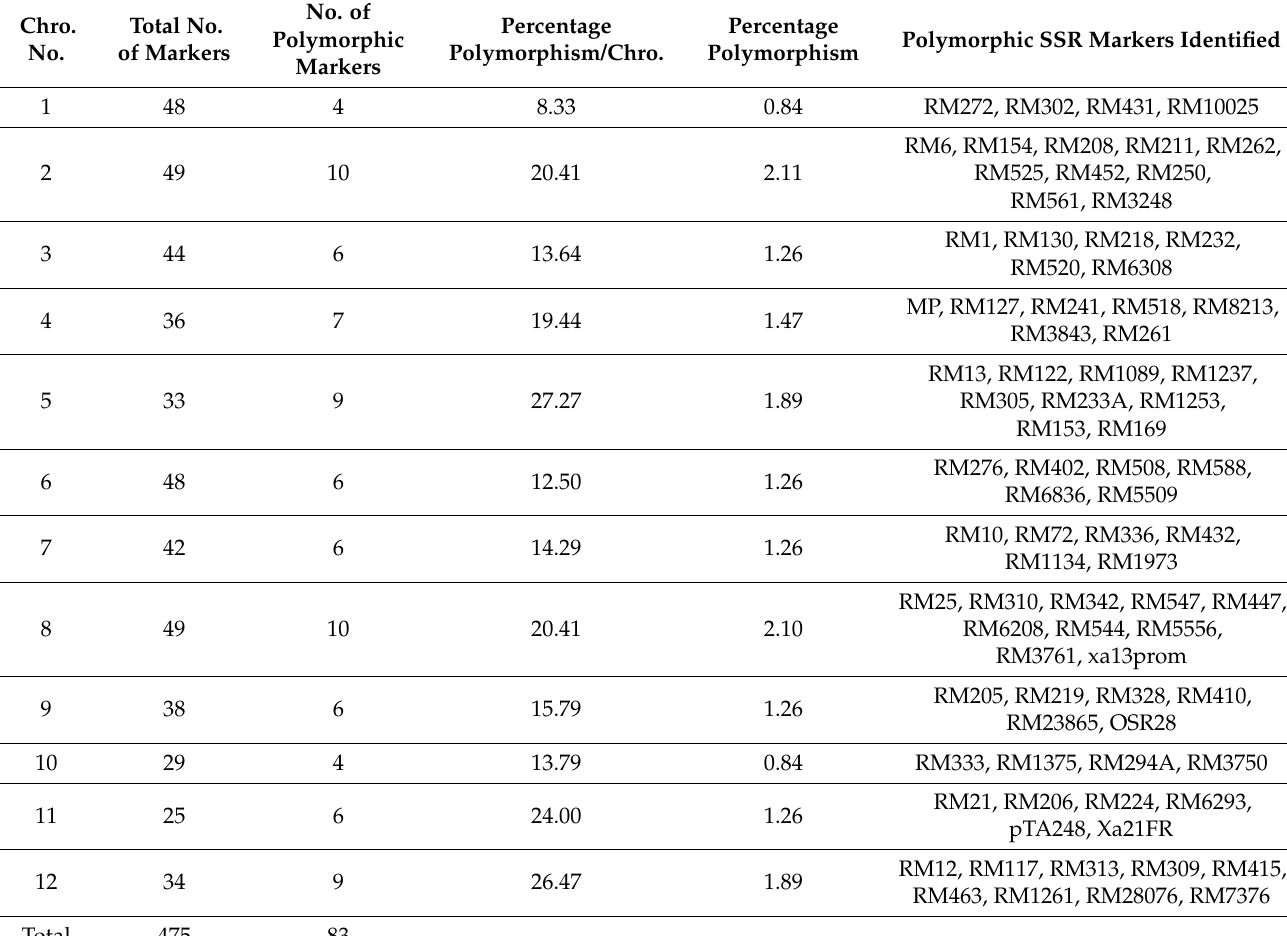
Table 1. Background selection with simple sequence repeating